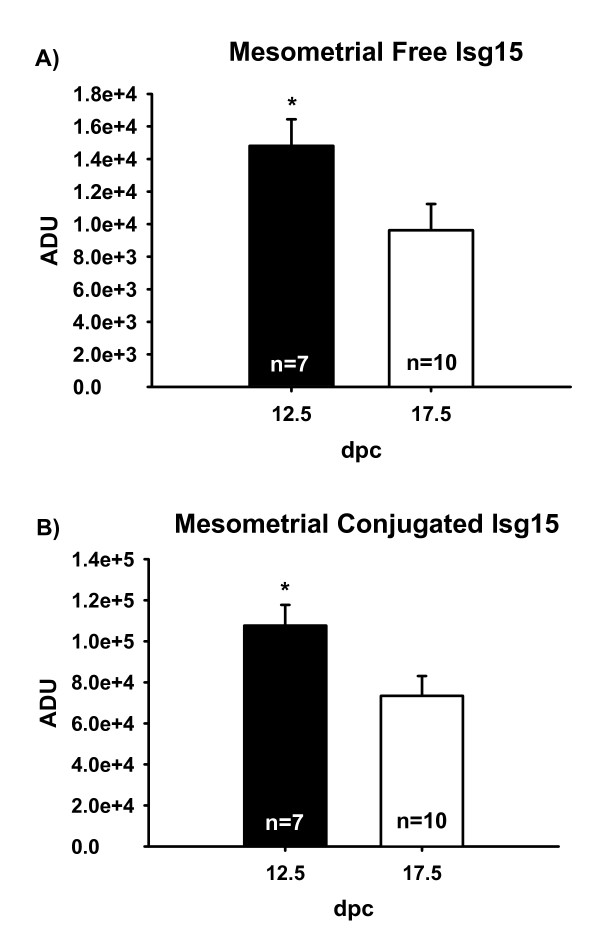
Mesometrial (MM) concentrations of free Isg15 (A) and conjugated Isg15 (B). Based on western blot detection of Isg15, MM had greater concentrations of Isg15 on 12.5 versus 17.5 dpc (A). MM also had greater concentrations of conjugated Isg15 on 12.5 dpc in contrast to 17.5 (B). Means are LSM ± SE. * denotes P < 0.05. Arbitrary densitometric units (ADU).